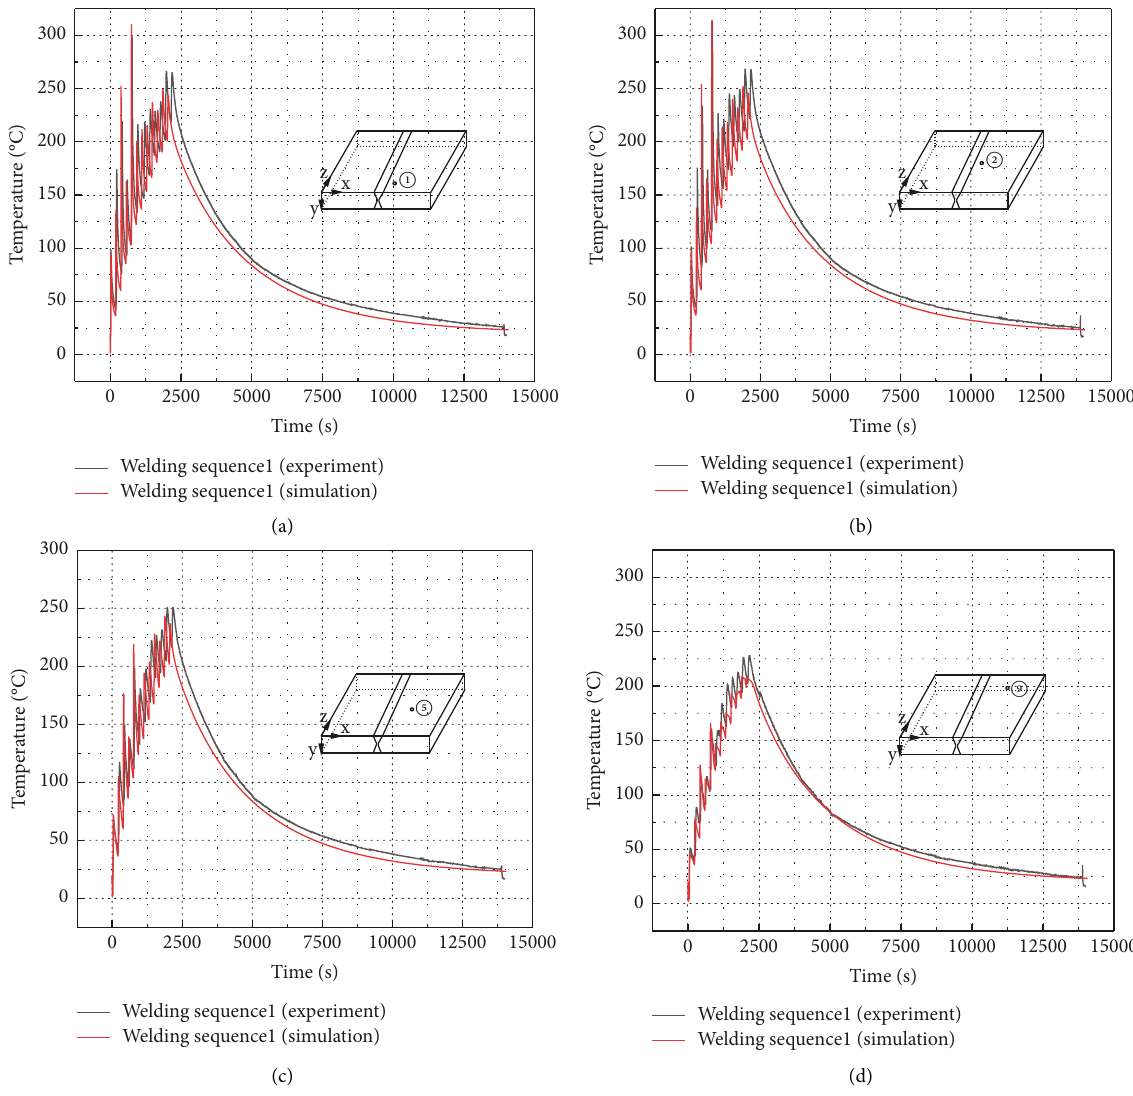
Figure 10: Comparison of measured temperature and simulated temperature. (a) Temperature history at point 1. (b) Temperature history at point 2. (c) Temperature history at point 5. (d) Temperature history at point